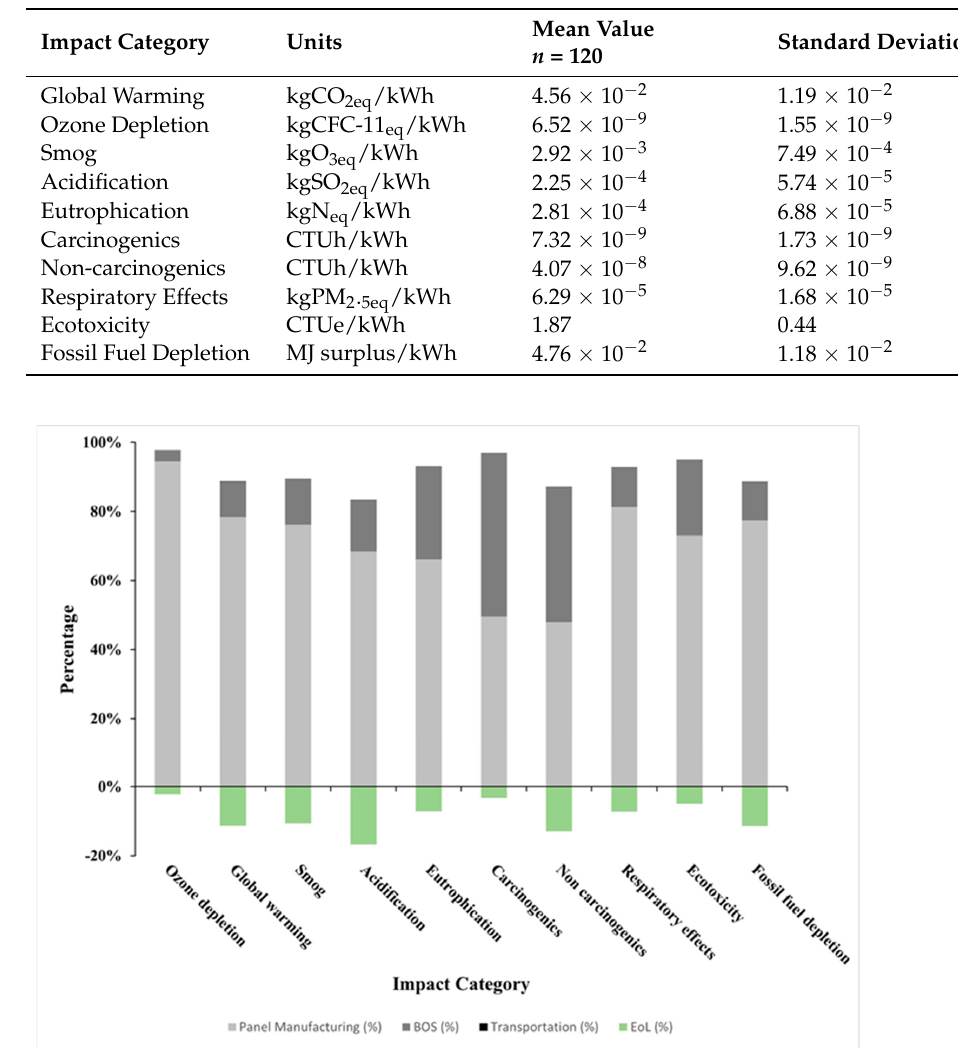
Figure 4. Contribution of panel manufacturing, the balance of system components